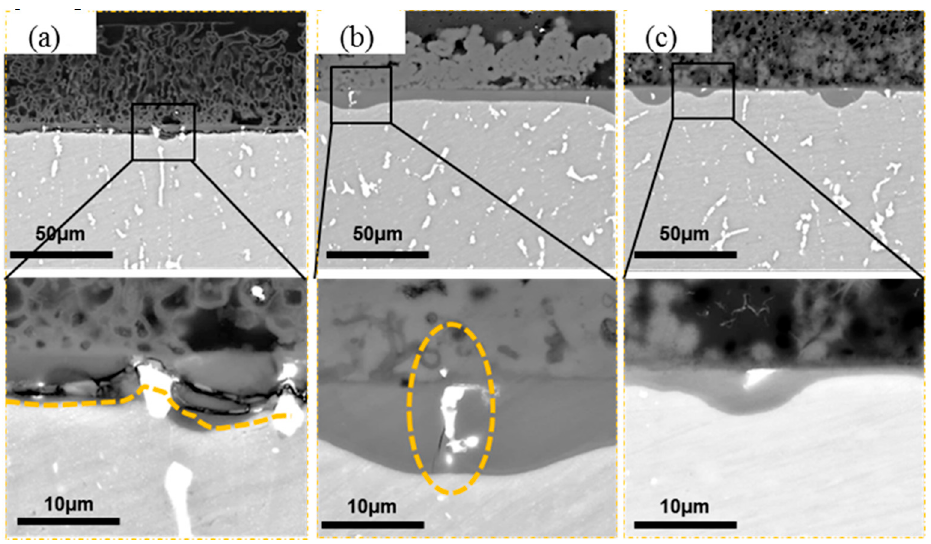
Figure 14. Cross-sectional morphology of the corrosion product layers formed on 2A02 Al alloy after corrosion for 200 h at ( a ) 30; ( b ) 60; ( c ) 80 °C.